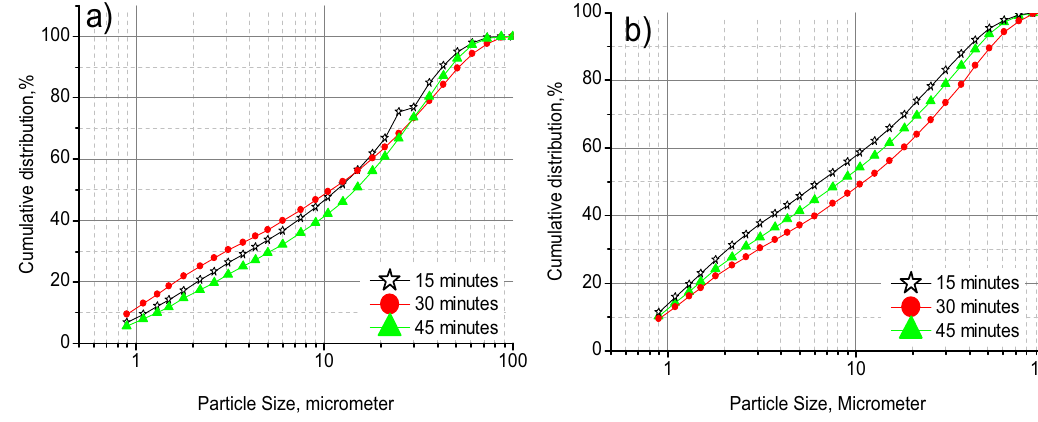
Figure 7: 50% BVT ( a ) and 50% GVT ( b ) blended types of cement ground at di ff erent